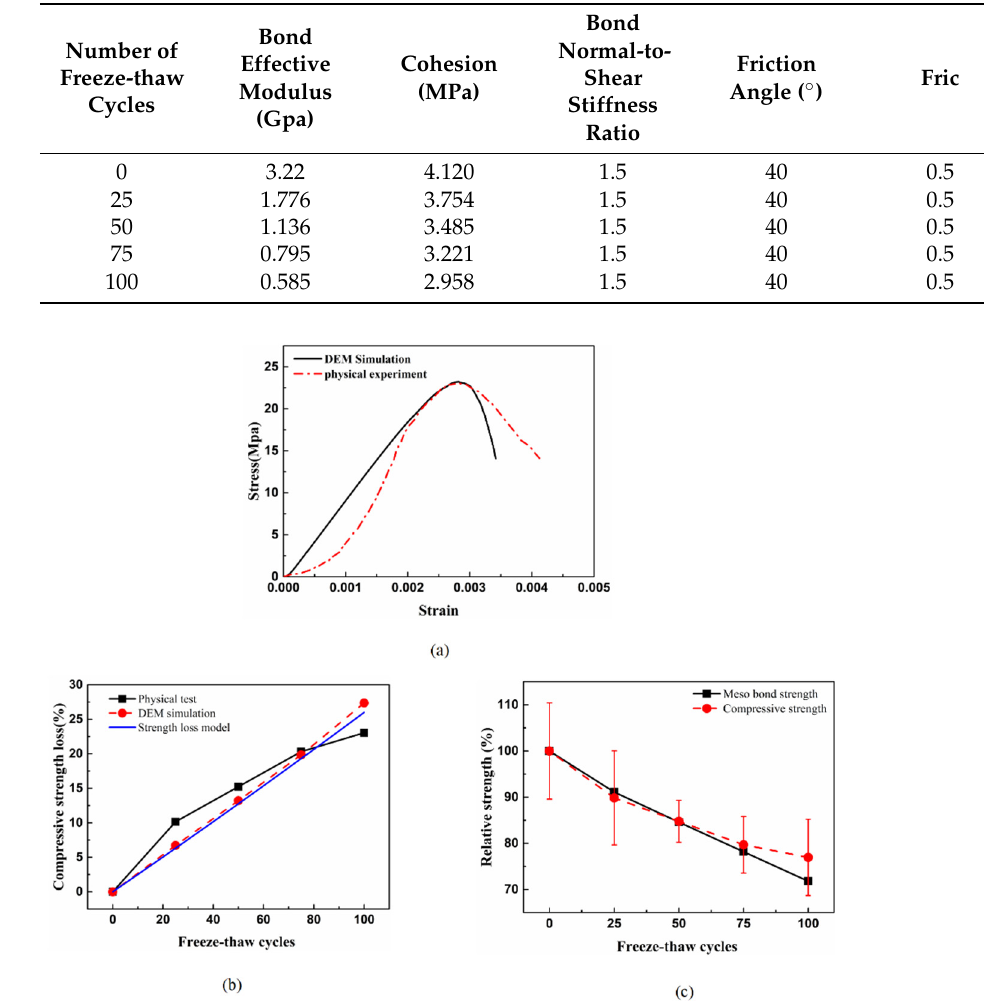
Figure 19. ( a ) Comparison of initial stress and strain curves of pervious concrete by discrete element simulation; ( b ) Comparison of strength loss DEM simulation value and test value; ( c ) Comparison of relative compressive strength and relative meso bond strength.